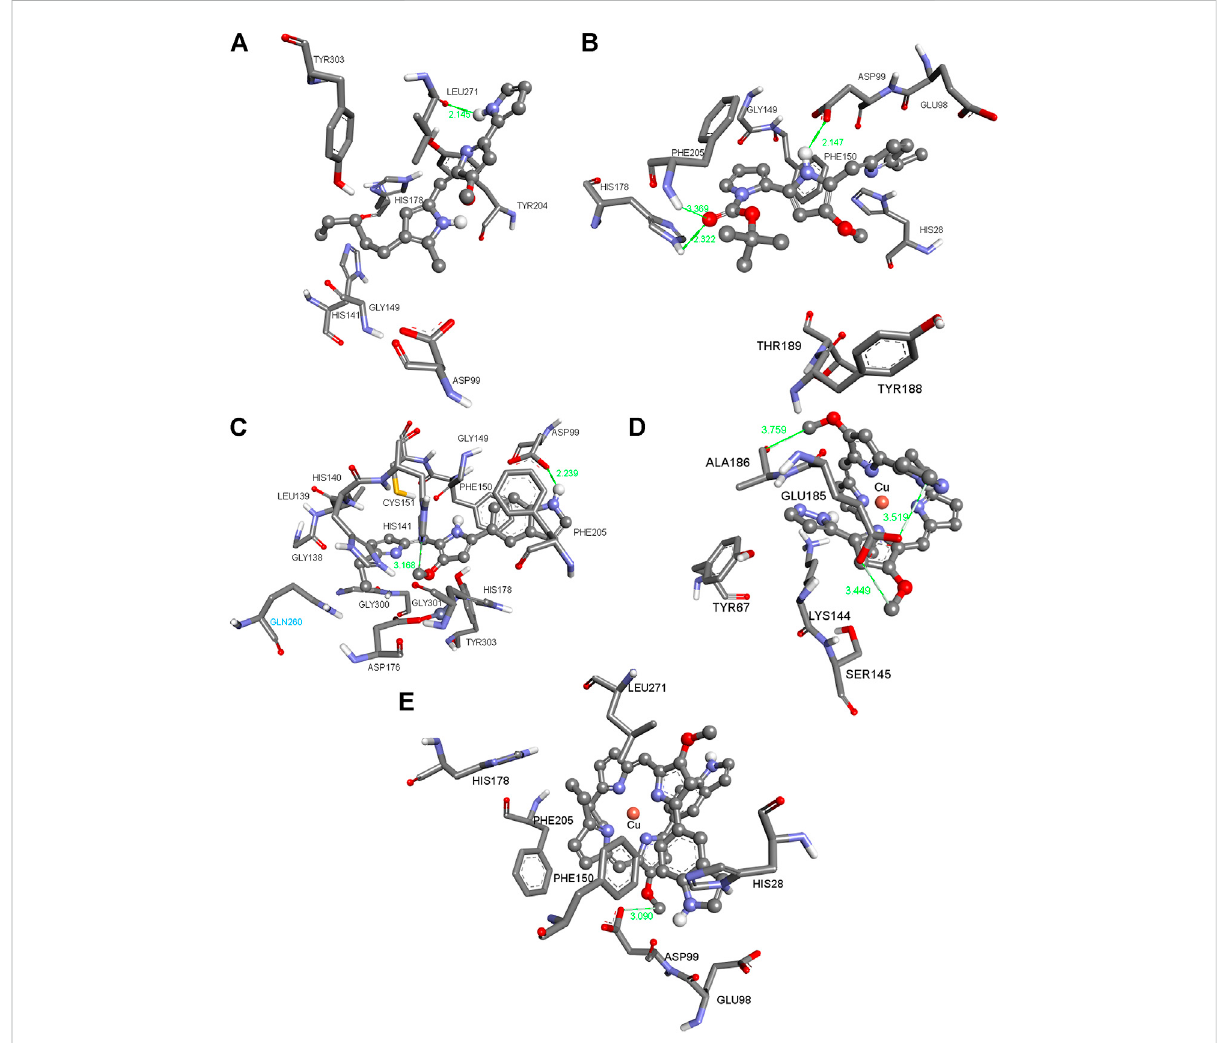
FIGURE 1 Three-dimensional(3D)imageswiththedisplayedhydrogenbondingdistances(ingreen)generated via moleculardockingof (A) Ps ,ligands (B) L 7 and (C) L 14 and copper (I) complexes (D) C9 and (E) C14 into HDAC1 enzyme. Amino acid side chains are shown as sticks, the ligands as ball and sticks, and the chelating atom coppers are depicted as round copper